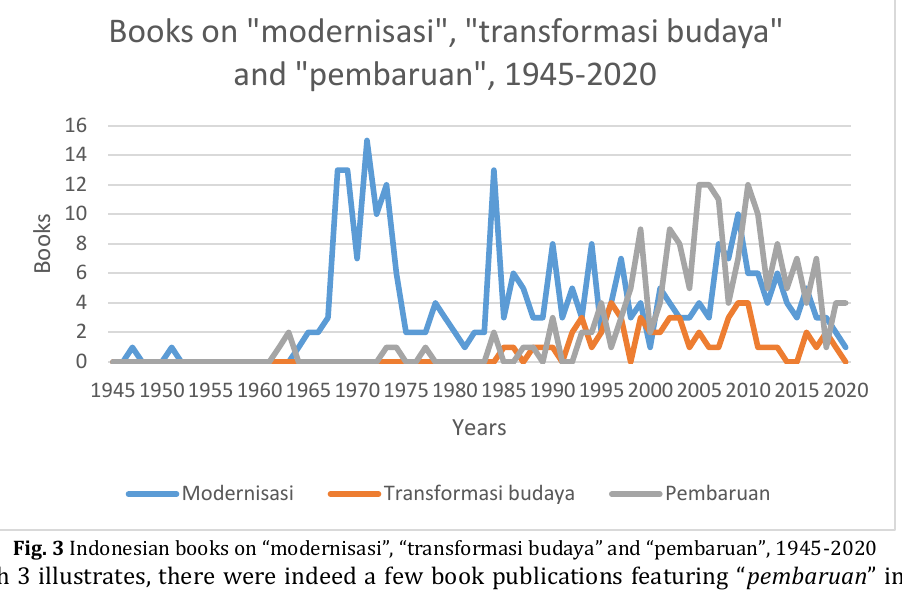
Fig. 3 Indonesian boo ks on “modernisasi”, “transformasi budaya” and “pembaruan”, 1945